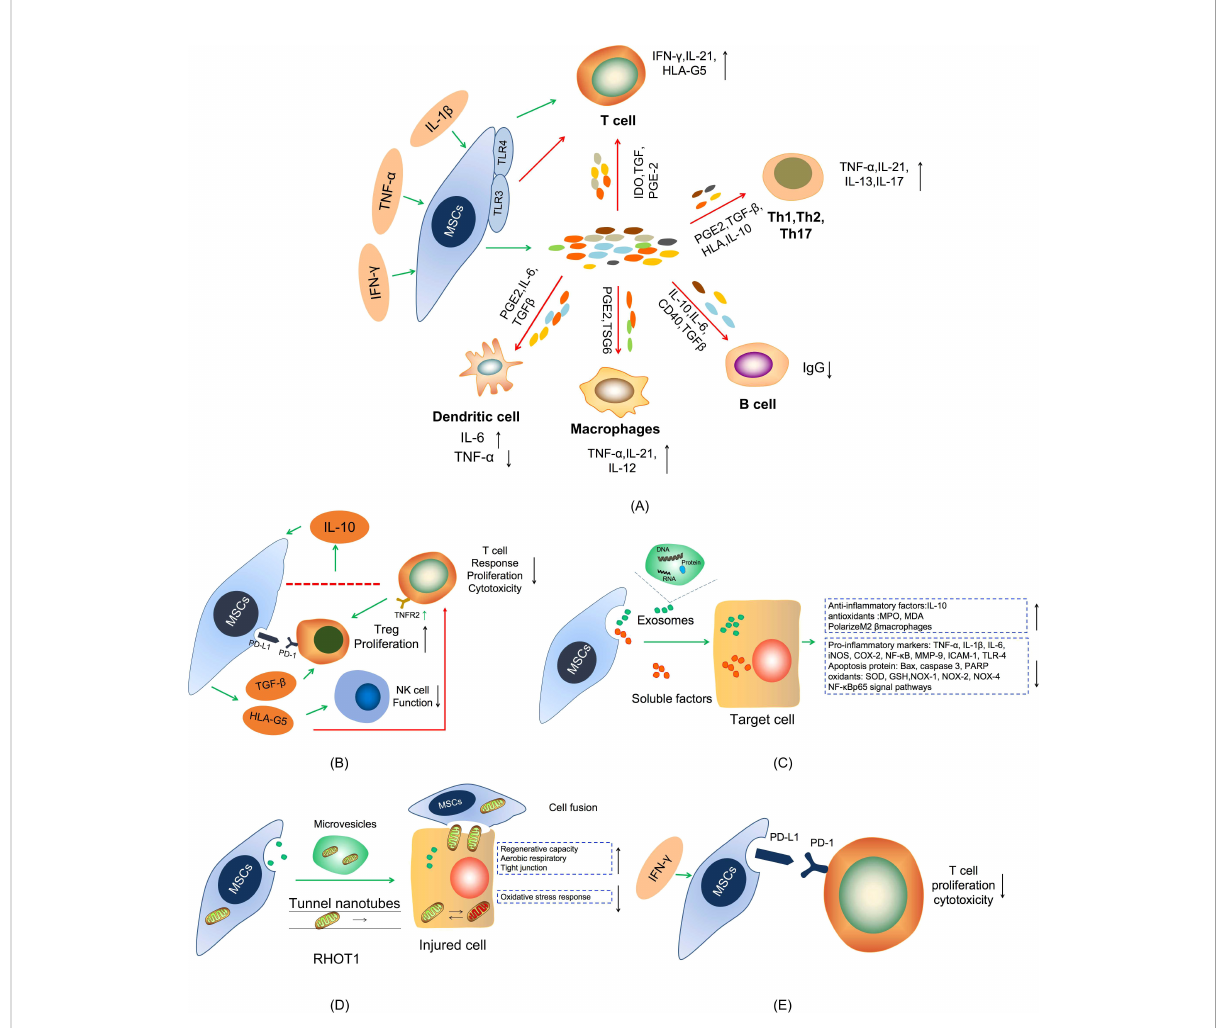
FIGURE 2 Schematic diagram of the mechanism of MSCs treatment in IBDs. (A) The secretion of anti-proliferative soluble factors. (B) Cell-To-Cell Contact. (C) Exosomes treatment. (D) Mitochondria transfer. (E) MSCs express